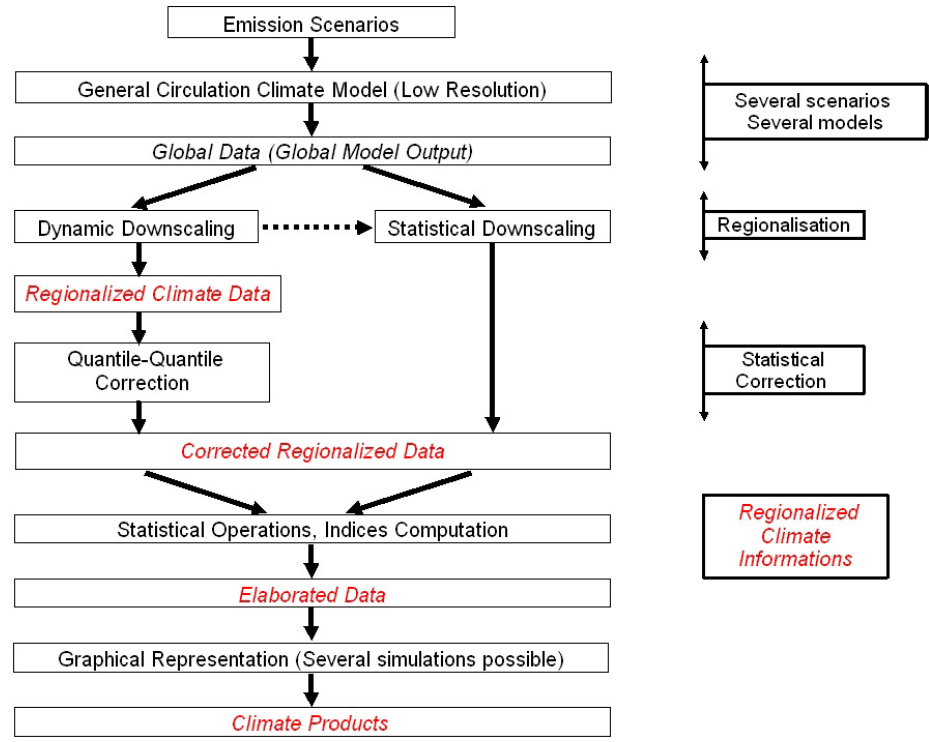
Figure 1. Production process modelling of regionalized climate information. Such a suite is complicated to understand for users. Moreover, each step introduces its own source of uncertainties, which add on the complexity of the delivered informations and